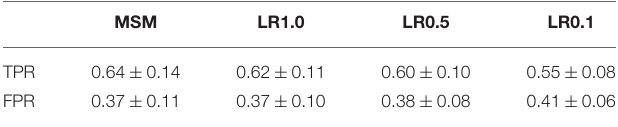
TABLE 1 | Mean and standard deviation, of true positive rate (TPR) and false positive rate (FPR) of each model, computed across across 50 subjects and including all the trials, i.e., before removing trials with no ERD.